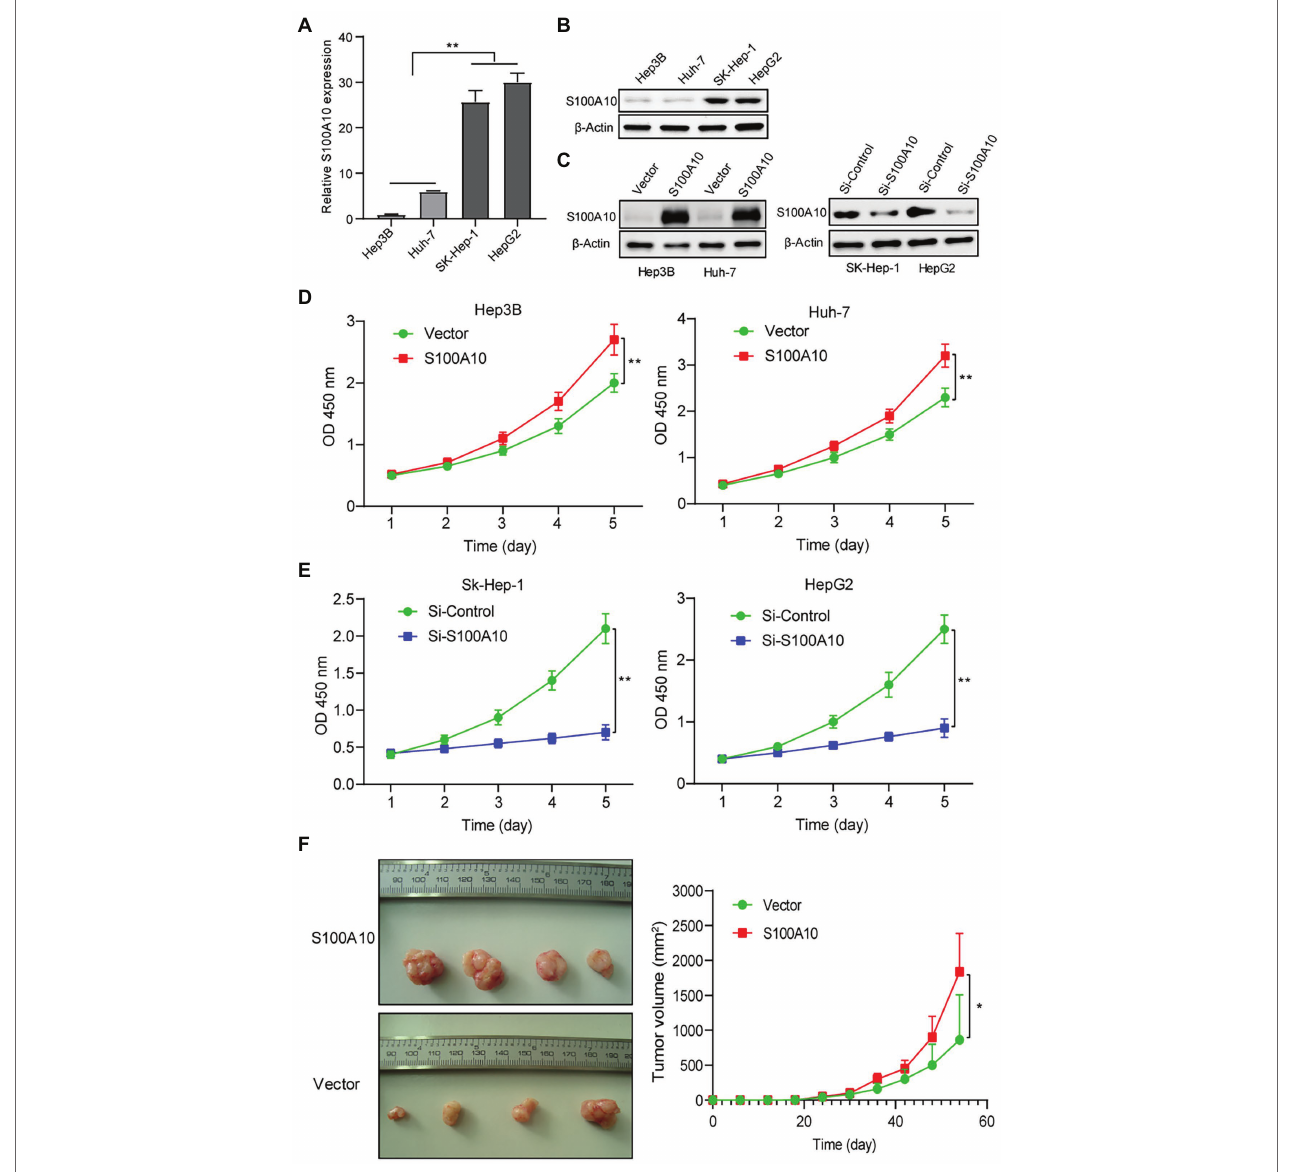
FIGURE 3 | S100 calcium binding protein A10 advances HCC growth in vitro and in vivo . (A) The mRNA level of S100A10 in HCC cell lines (Hep3B, Huh-7, SK- Hep-1, and HepG2). (B) The protein level of S100A10 in HCC cell lines. (C) The level of S100A10 in treated HCC cell lines were accessed by western blotting. (D) Cell Counting kit 8 (CCK-8) indicated overexpressing S100A10 enhanced the proliferation of Hep3B, Huh-7 cells. (E) Knocking down S100A10 blocked SK- Hep-1 and HepG2 cell growth. (F) Overexpressing S100A10 enhanced the subcutaneous growth of Huh-7 cells in nude mice. * p < 0.05; ** p <